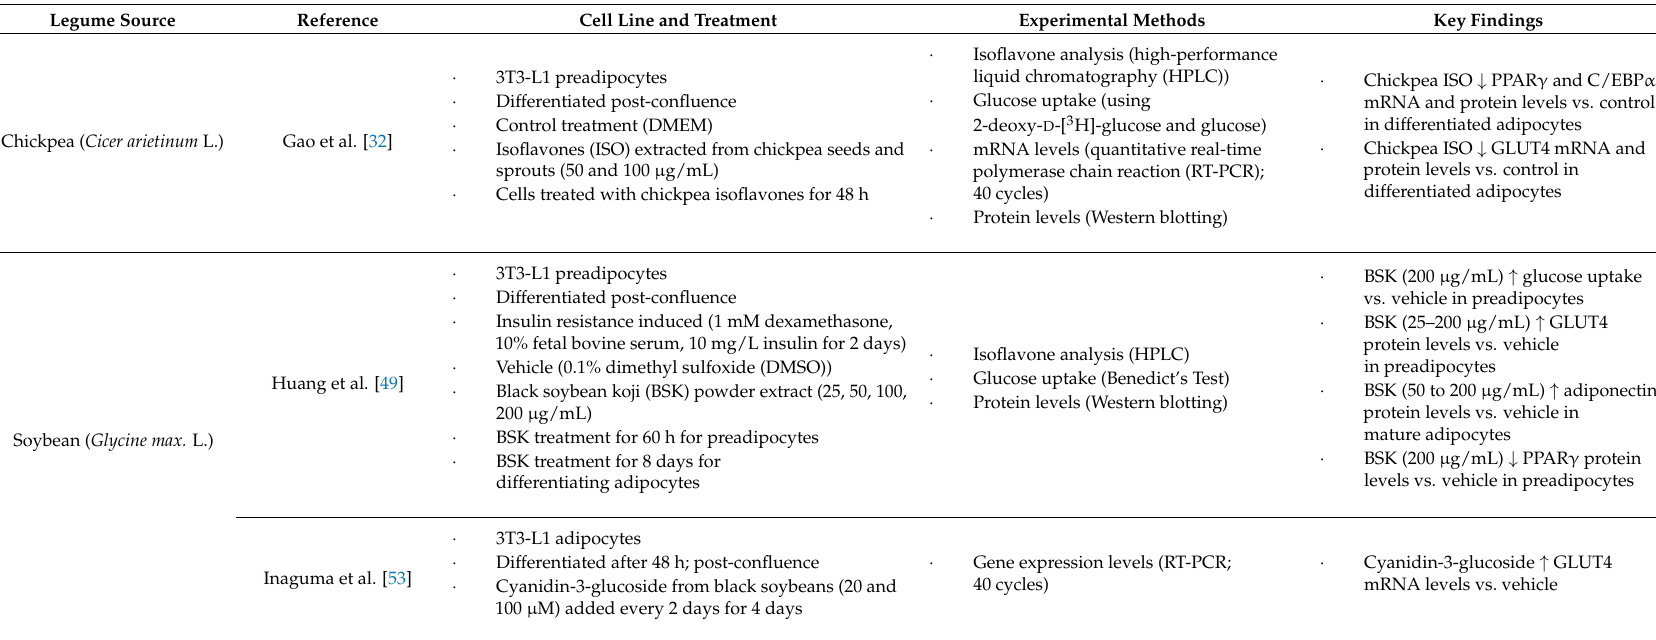
Table 3. Summary of the in vitro studies included in the present